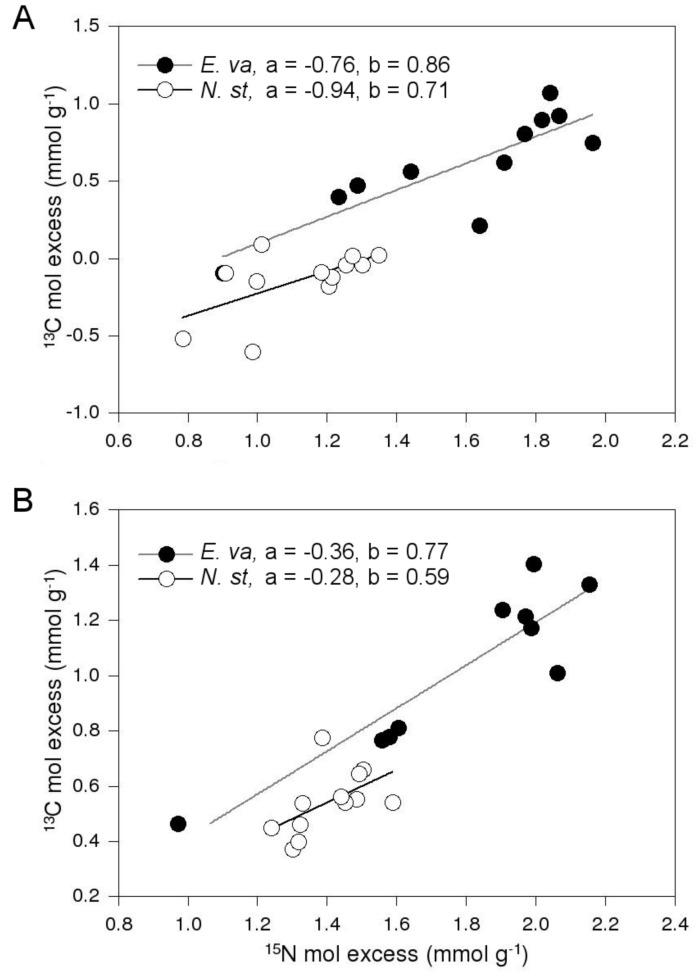
Isotopic enrichment in plant tissue.Regression analysis and parameter estimates (a = intercept with the ordinate, b = slope) of log transformed data of 15N against 13C mol excess for shoot (a) and root (b) biomass of plants treated with dual-labelled (13C and 15N) glycine+unlabelled NH4
+. E. va = E. vaginatum, N. st = N. stricta.